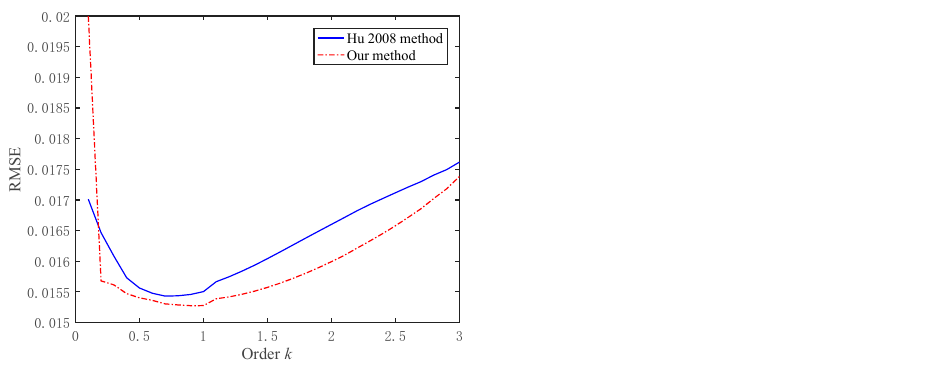
Figure 2. The relationship between the order k and the RMSE in the data of the simulated K-distribution.